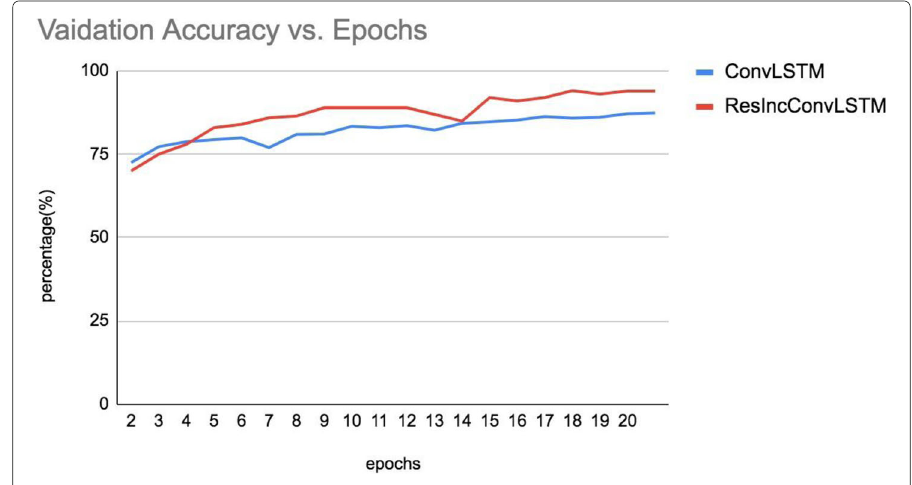
Fig. 7 Validation accuracy vs. epochs